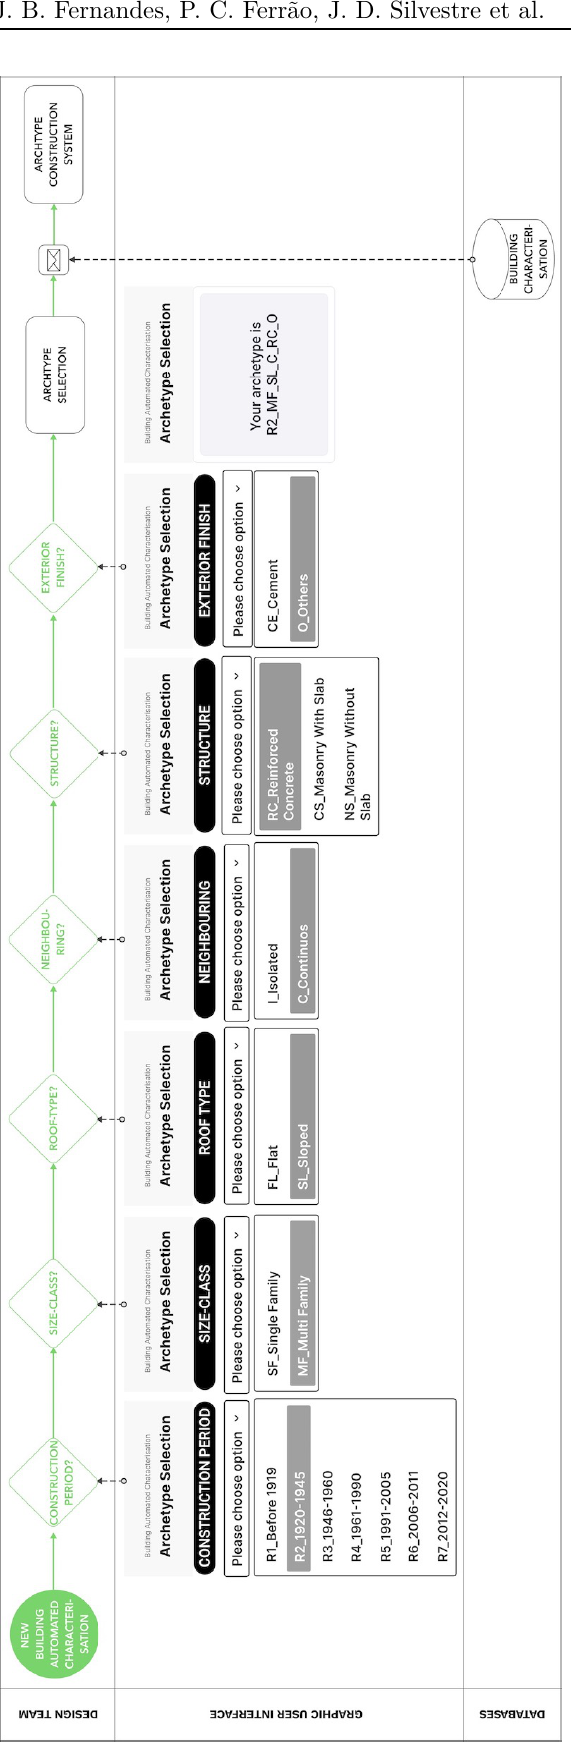
Figure 3. Building Automated Characterisation